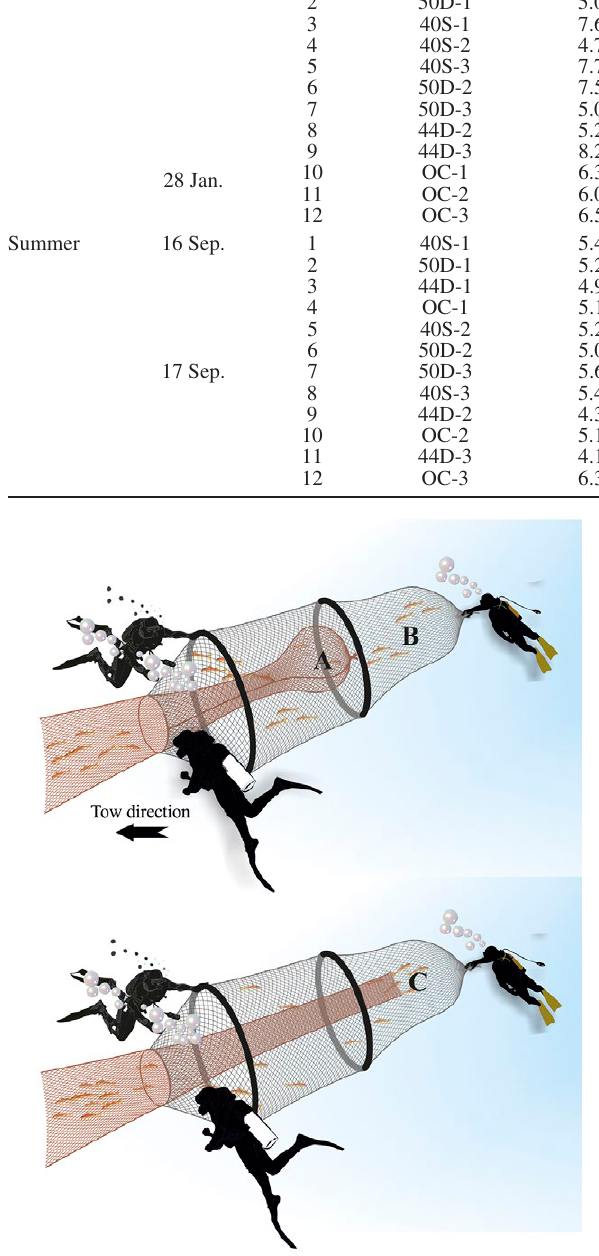
Fig. 2. – A, fish retained in the codend; B, fish that escaped from the codend; C, fish caught in the cover with the open